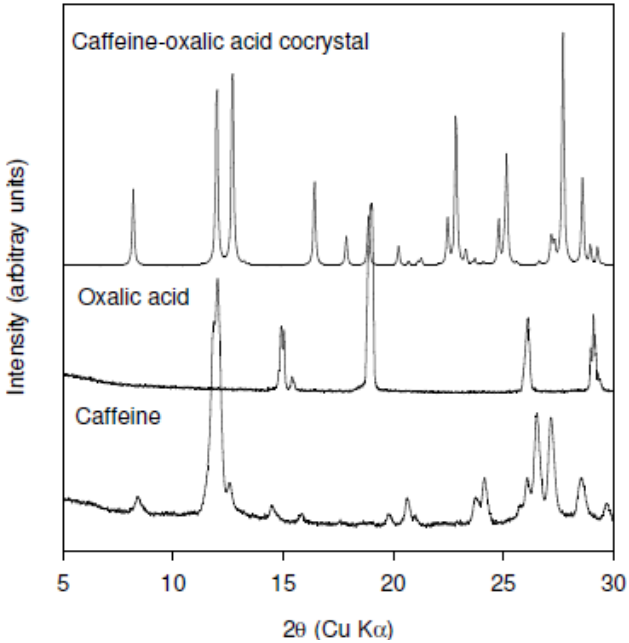
Figure 2. XRPD patterns of as-received Caffeine and as-received Oxalic acid, and Caffeine-oxalic acid cocrystal. Pattern for Caffeine-Oxalic acid cocrystal was calculated from the published crystal structure obtained from the Cambridge Structural Database